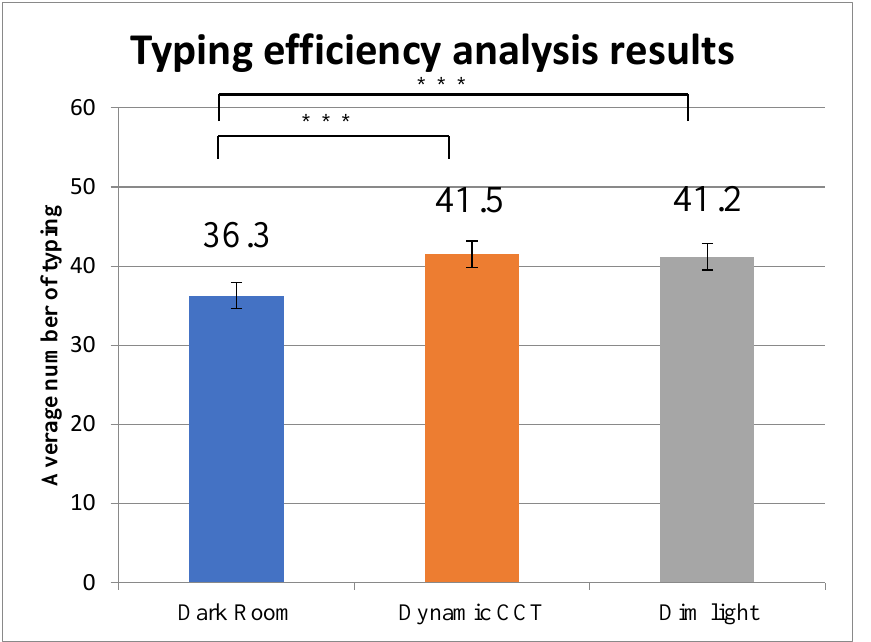
Figure 13. Dark room, Dynamic CCT and Dim light typing efficiency comparison chart per minute in sleep environment. “ *** ” is p < 0.001.